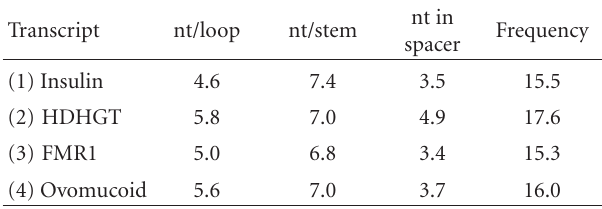
Table 3: Frequency of stem loops in primary pre-mRNA tran- scripts. The simple stem loops with minimal 3 nucleotides in the loop and minimal 3 base pairs in the stem consisting of AU, GC, and GU pairs have been constructed with the aid of a computer [46]. The total number of nucleotides were divided by numbers of stem loops for frequency. The number of nucleotides in each loop and each stem and spacer were counted and averages were